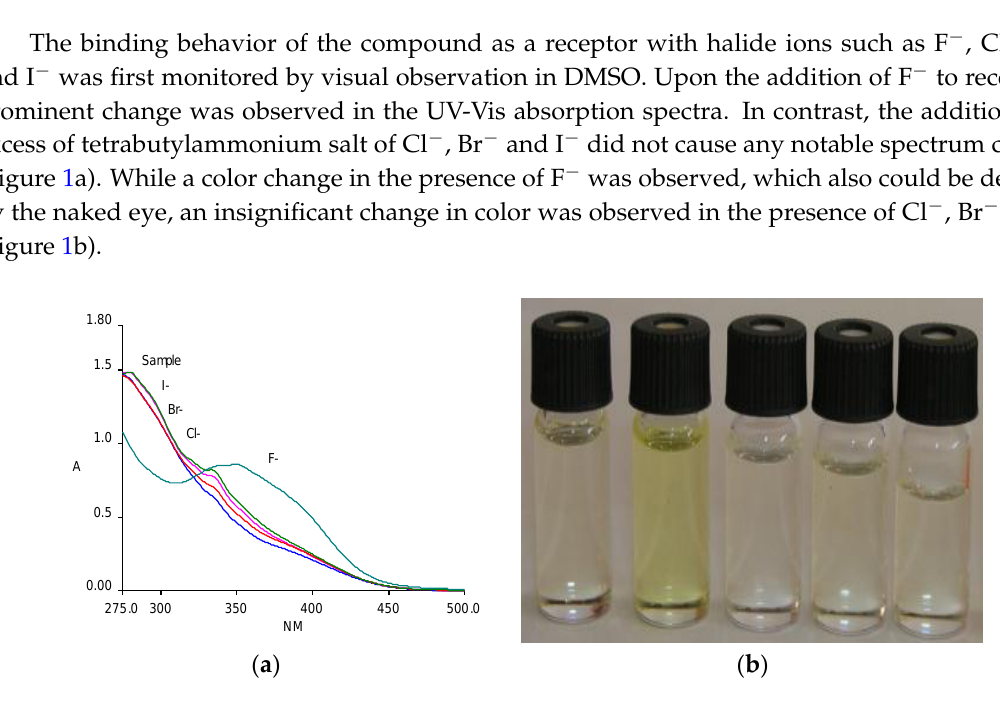
Figure 1. (a) UV-vis absorption changes of compound 3 (0.01 mM) upon addition of tetrabutylammonium salt of halides in DMSO; ( b) The color changes of compound ( 3 ) in DMSO solution (0.01 mM), from left to right, upon addition of 1 equiv. of tetrabutylammonium ions; free, F − , Cl − , Br − and I − .